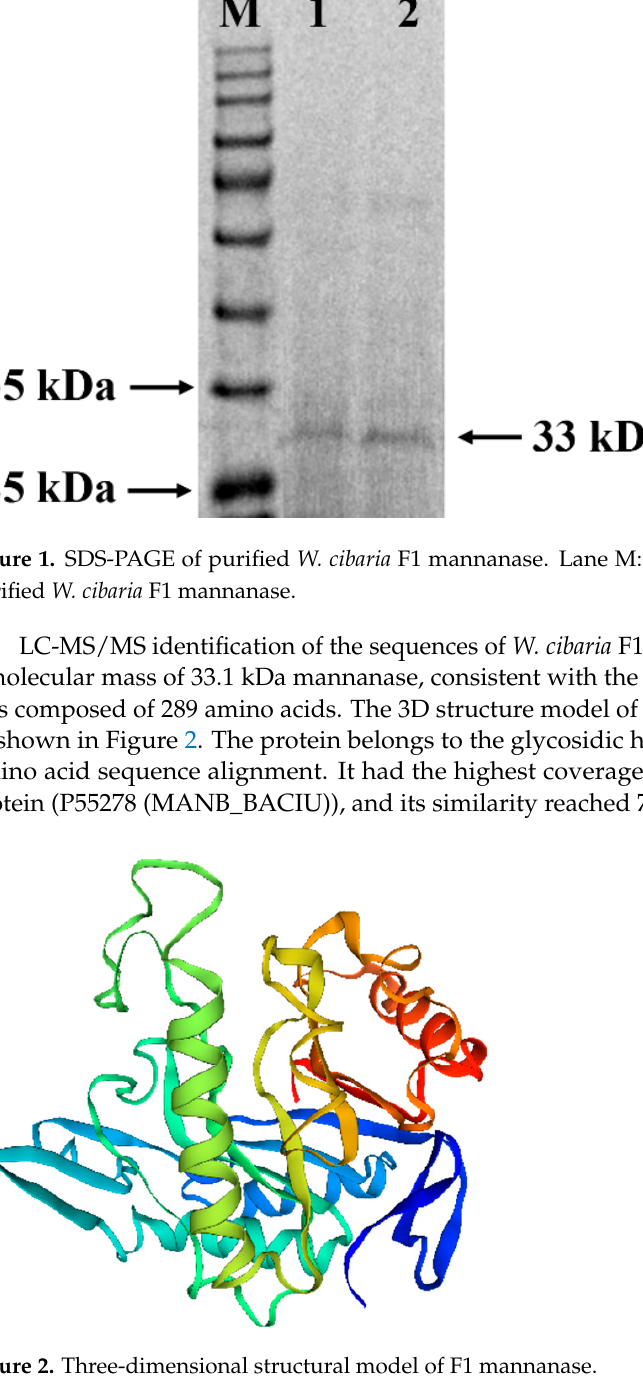
Figure 2. Three-dimensional structural model of F1 mannanase.